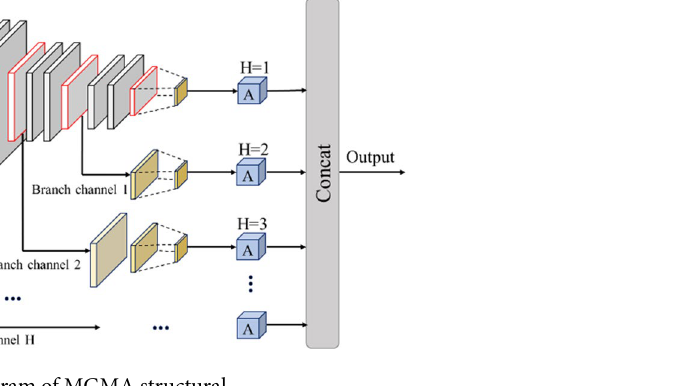
Figure 6. The diagram of MGMA